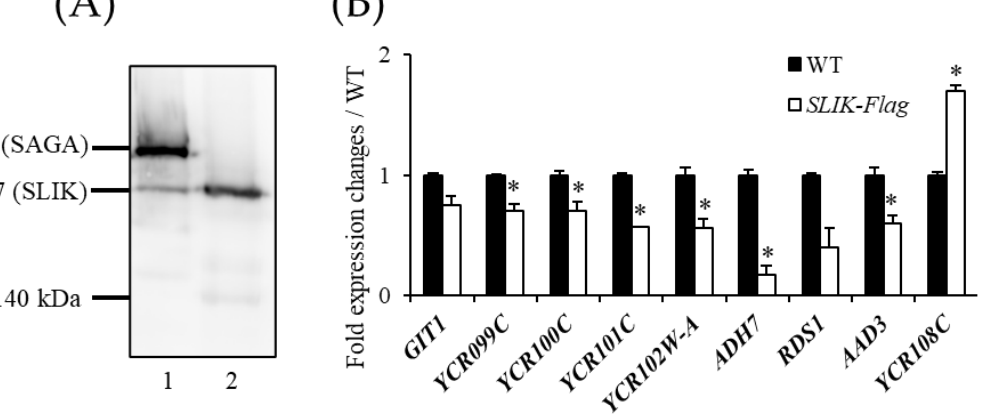
Figure 6. The SLIK complex is not sufficient for boundary formation. ( A ) Western blot analysis of protein extracts from strains producing Flag-Spt7 (lane 1) or SLIK-specific Spt7-Flag (lane 2). A 6% acrylamide gel was used for protein fractionation. Flag-tag was detected by an anti-Flag antibody. ( B ) Expression level of Chr III genes in the SLIK-Flag strain by RT-qPCR. Asterisks represent p < 0.05 compared with the WT (Student’s T-test). Error bars show standard errors calculated from three independent experiments.